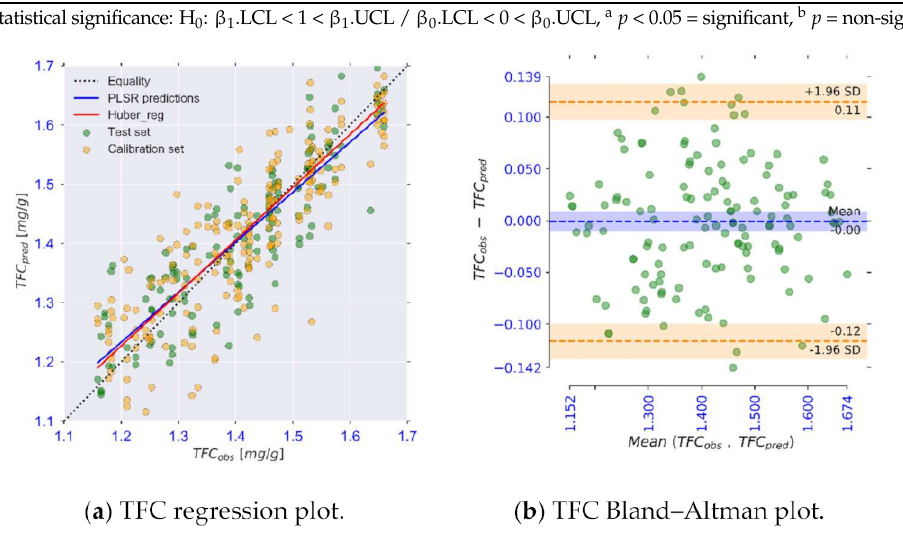
Figure 11. Regression plot and Bland-Altman plot for